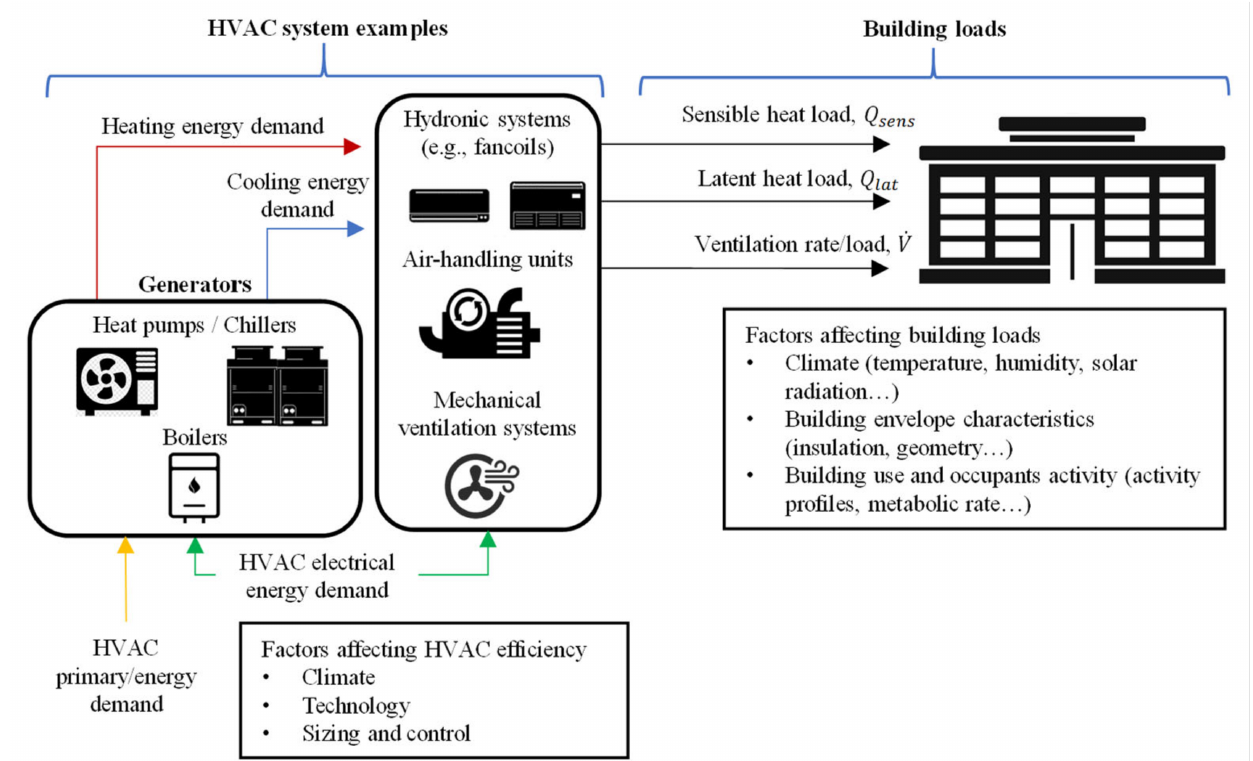
Figure 2. HVAC systems and typical energy flows